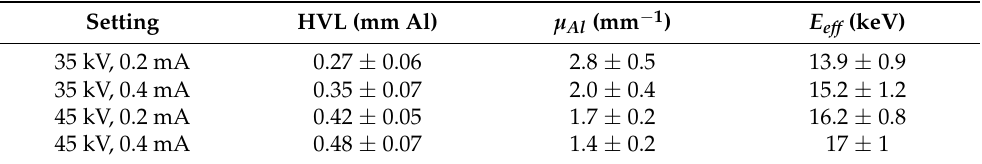
Figure 5. Calibration curve used to convert TLD-output into absorbed dose in water for 60 Co photons. Half-value layers (HVL), effective linear attenuation coefficients ( µ Al ), and effective energies ( E ff ) values for the different combinations of voltage and filament current in the X-ray tube are presented in Table 5; no statistical differences between values with the same kV were observed. The average value of the effective energy of the X-ray beam was calculated from these data as 14.5 ± 0.9 keV for 35 kV and 16.6 ± 0.6 keV for 45 kV. Table 5. HVL, µ Al , and E eff determined for different settings of voltage and current parameters in the X-ray tube.